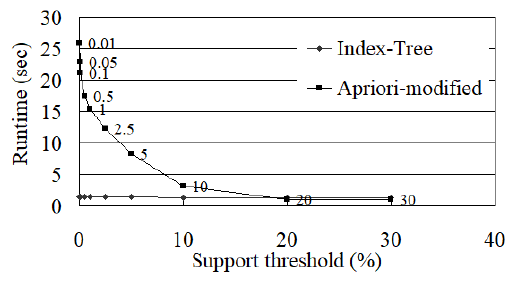
Fig. 14 Runtime vs. support threshold (d = 100k, n = 100, m = 5%).